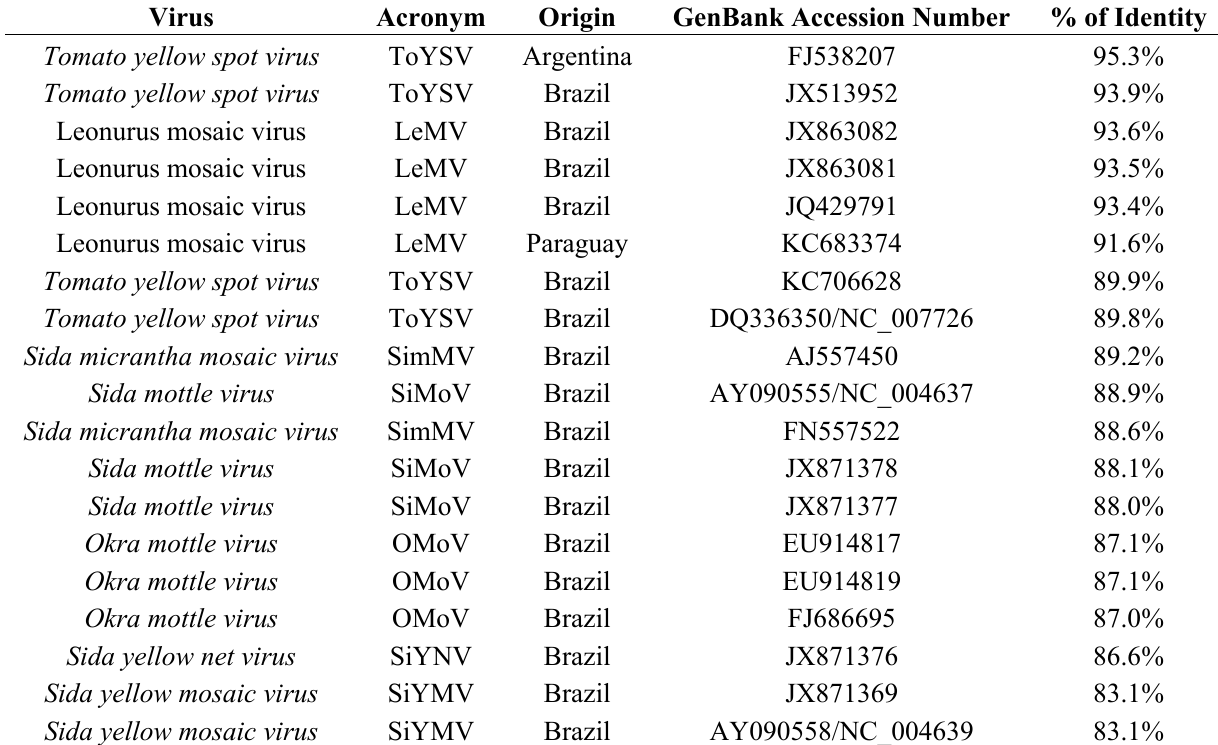
Table 1. Nucleotide identity of the DNA-A sequence of Tomato yellow spot virus isolated from chia (clone